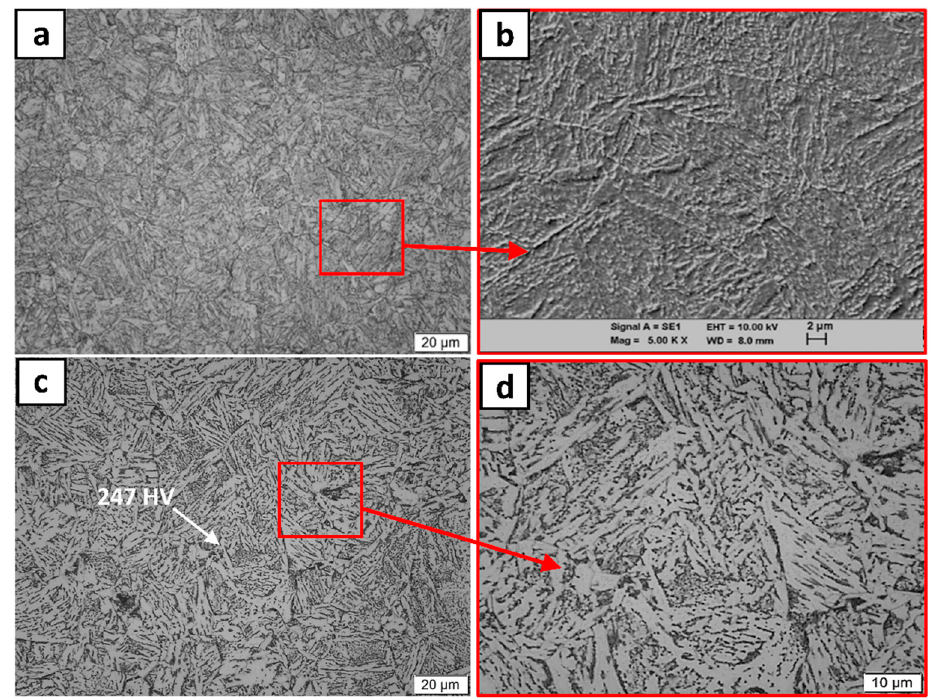
Figure 11. ( a ) Martensite; ( b ) enlarged detail of ( a ); ( c ) acicular ferrite and pearlite in the shaft core; ( d ) enlarged detail of ( c